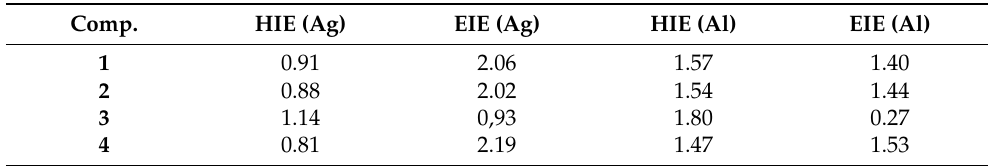
Table 2. The hole/electron injection energy (EIE/HIE) barriers from of Schiff base compounds to Silver (Ag)/Aluminum (Al) electrodes were assessed at B3LYP/6-31+G** level. Comp. HIE (Ag) EIE (Ag)